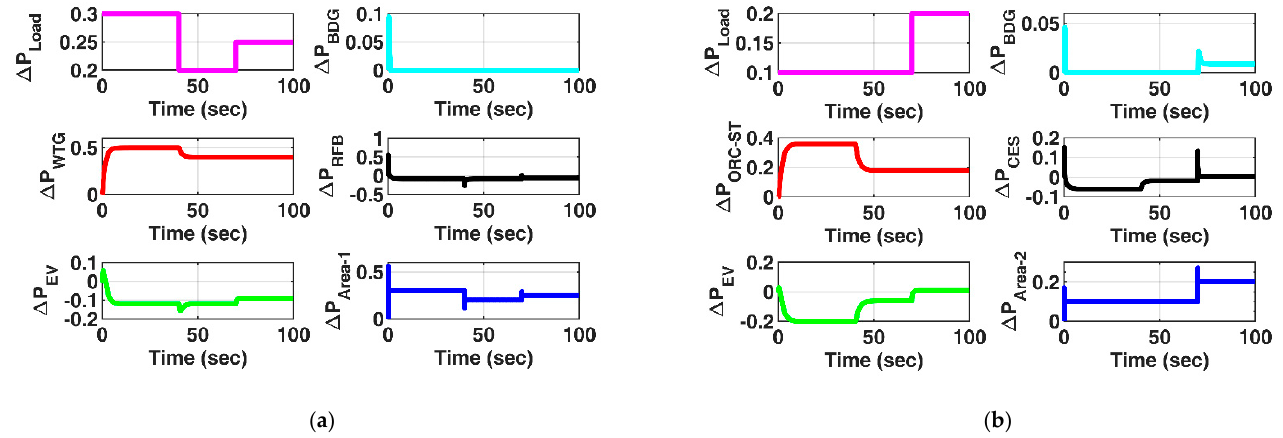
Figure 10. ( a ) Power responses of MG components of area 1. ( b ) Power responses of MG components of area 2.